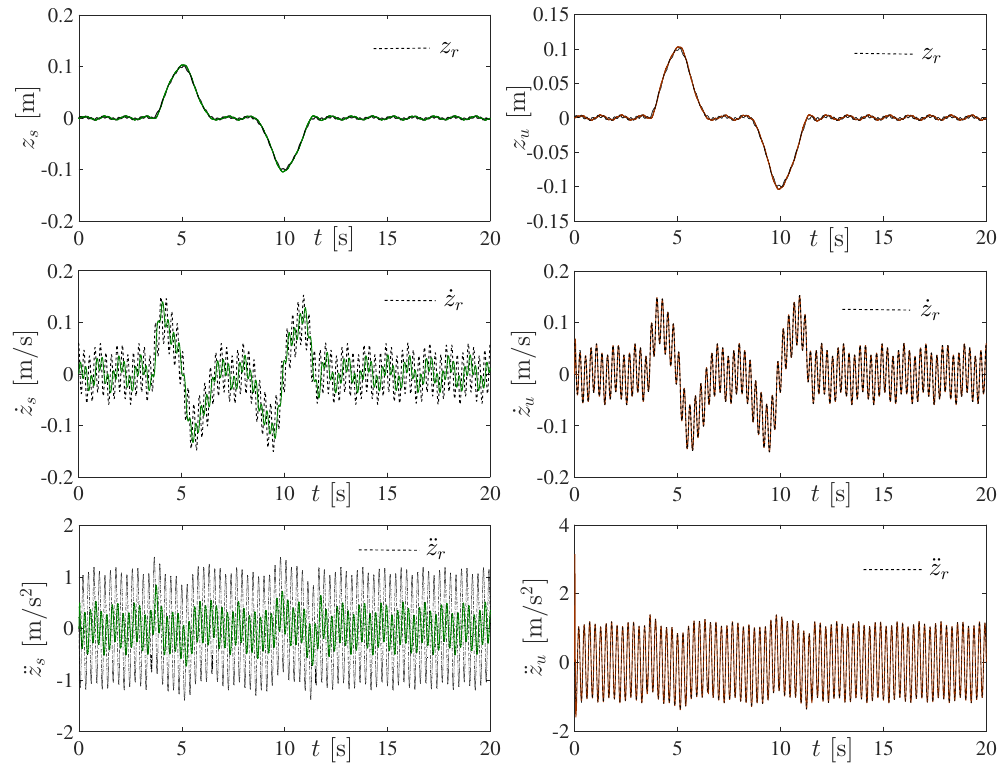
Figure 5. Responses of the passive suspension system subject to irregular road disturbances.